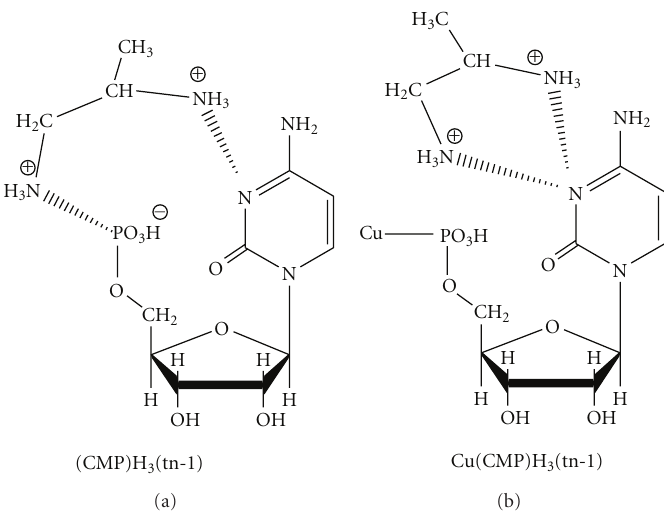
Figure 6: Tentative mode of interaction in (CMP)H 3 (tn-1) and Cu(CMP)H 3 (tn-1) complexes.